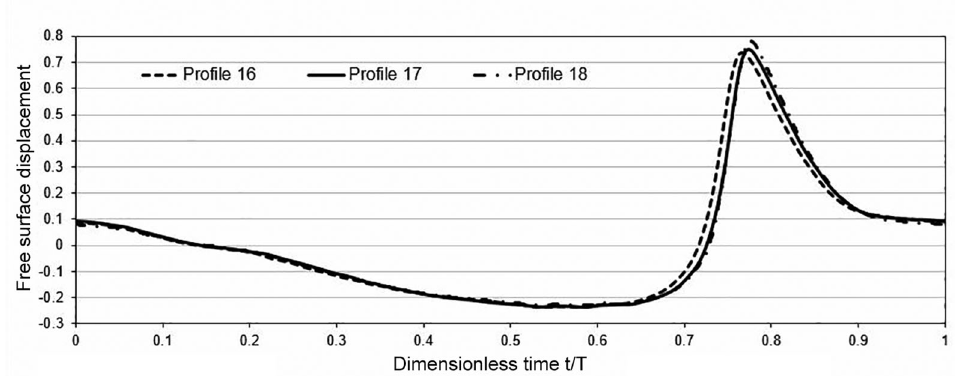
Fig. 3. The mean free surface displacement for three profiles. The profile numbers correspond to the location of measuring profiles 16, 17 and 18 in Table